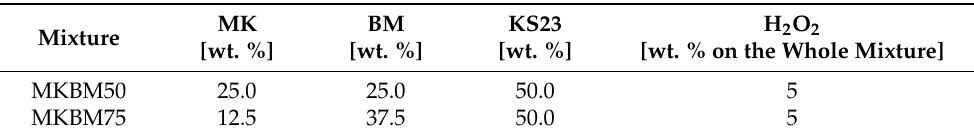
Table 2. Geopolymer mixture